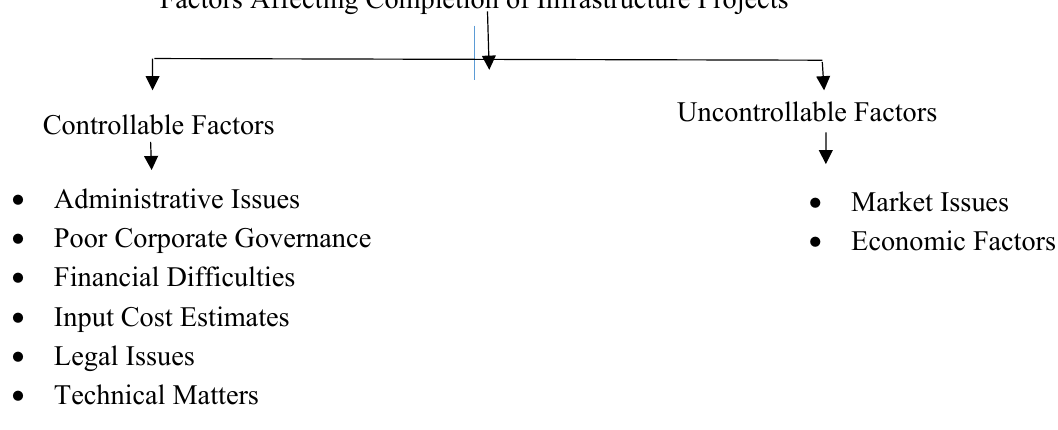
Fig. 5. Major Factors of Infrastructure Projects